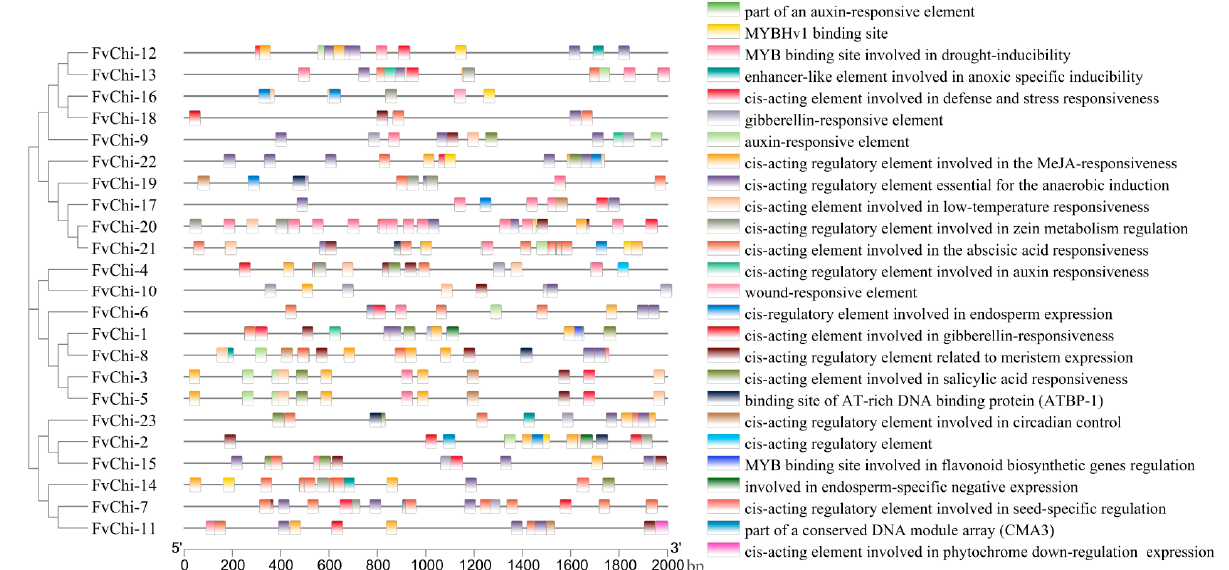
Figure 5. Promoter analysis of FvChi genes.